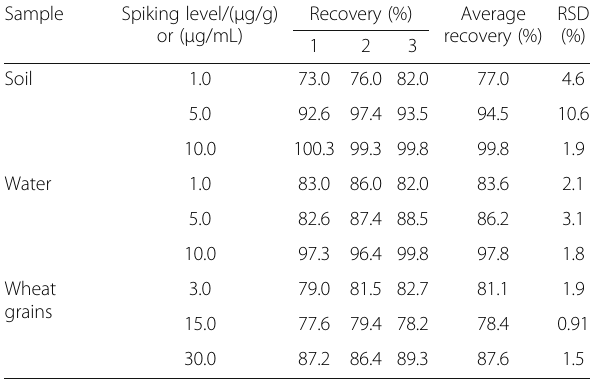
Table 6 Residue of PXD found in real samples of soil